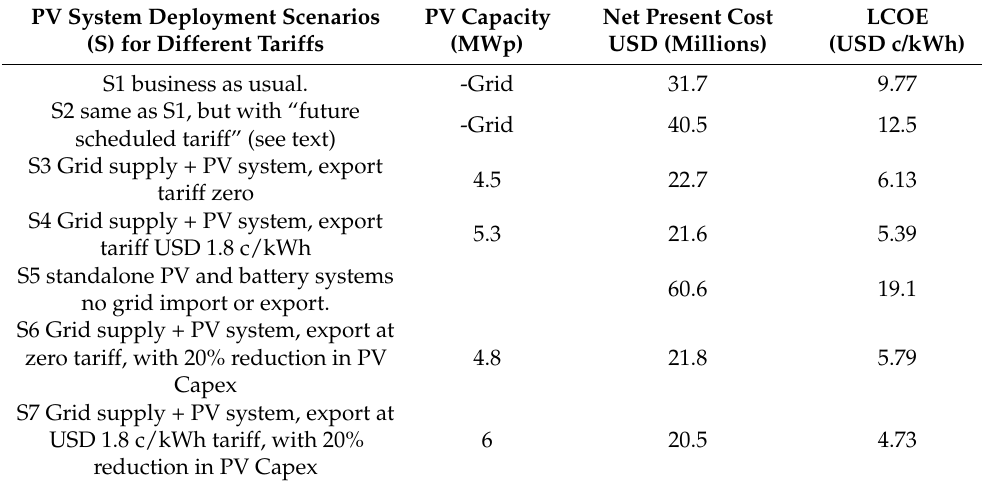
Table 4. PV capacity and levelized cost of energy (LCOE) under different